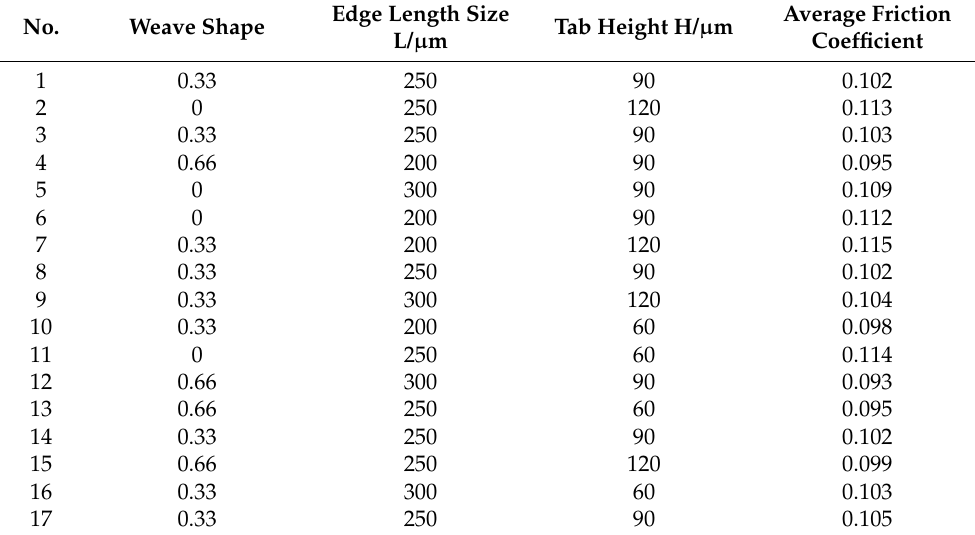
Table 11. Response of the average friction